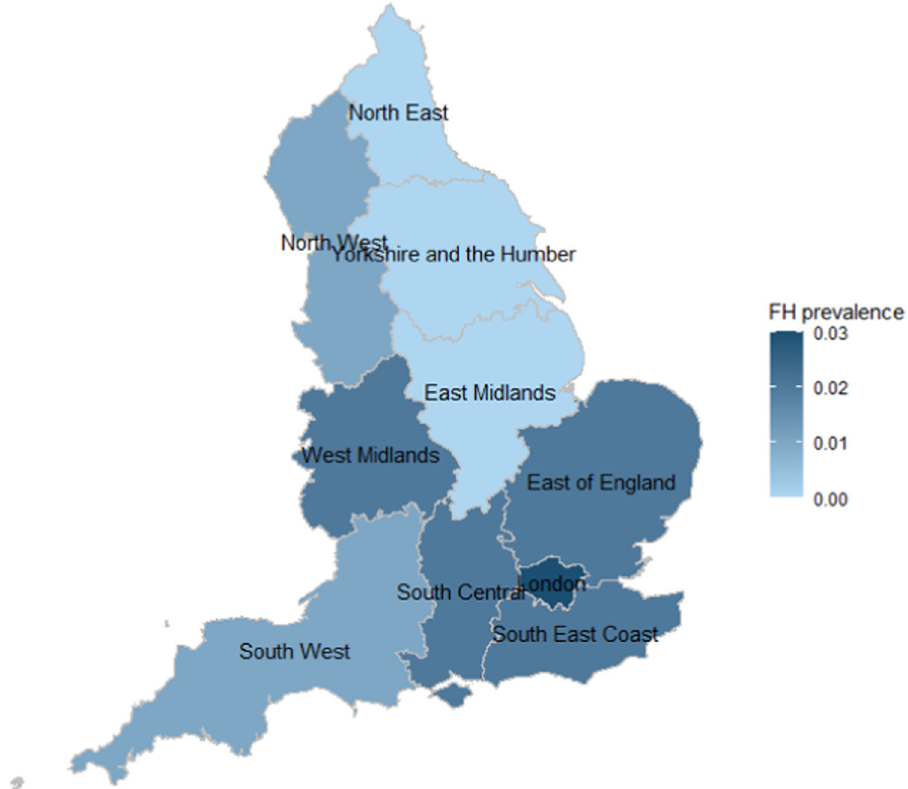
Fig. 1 Map of familial hypercholesterolaemia prevalence. Reported prevalence of familial hypercholesterolaemia in primary care electronic health records by English